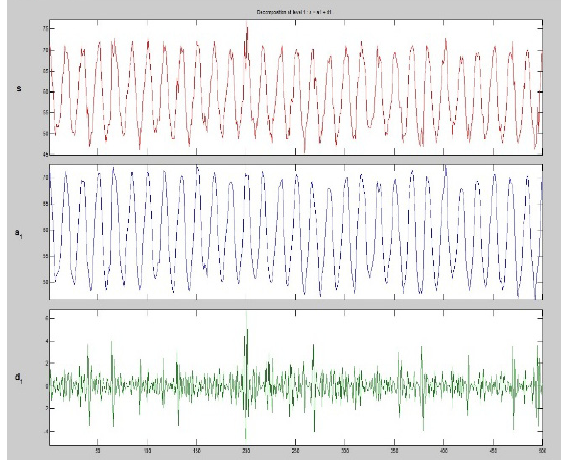
Figure 8. Images obtained from wavelet analysis – forces after dry turning with diamond insert CD10 at v c = 150 m/min and f =0.27